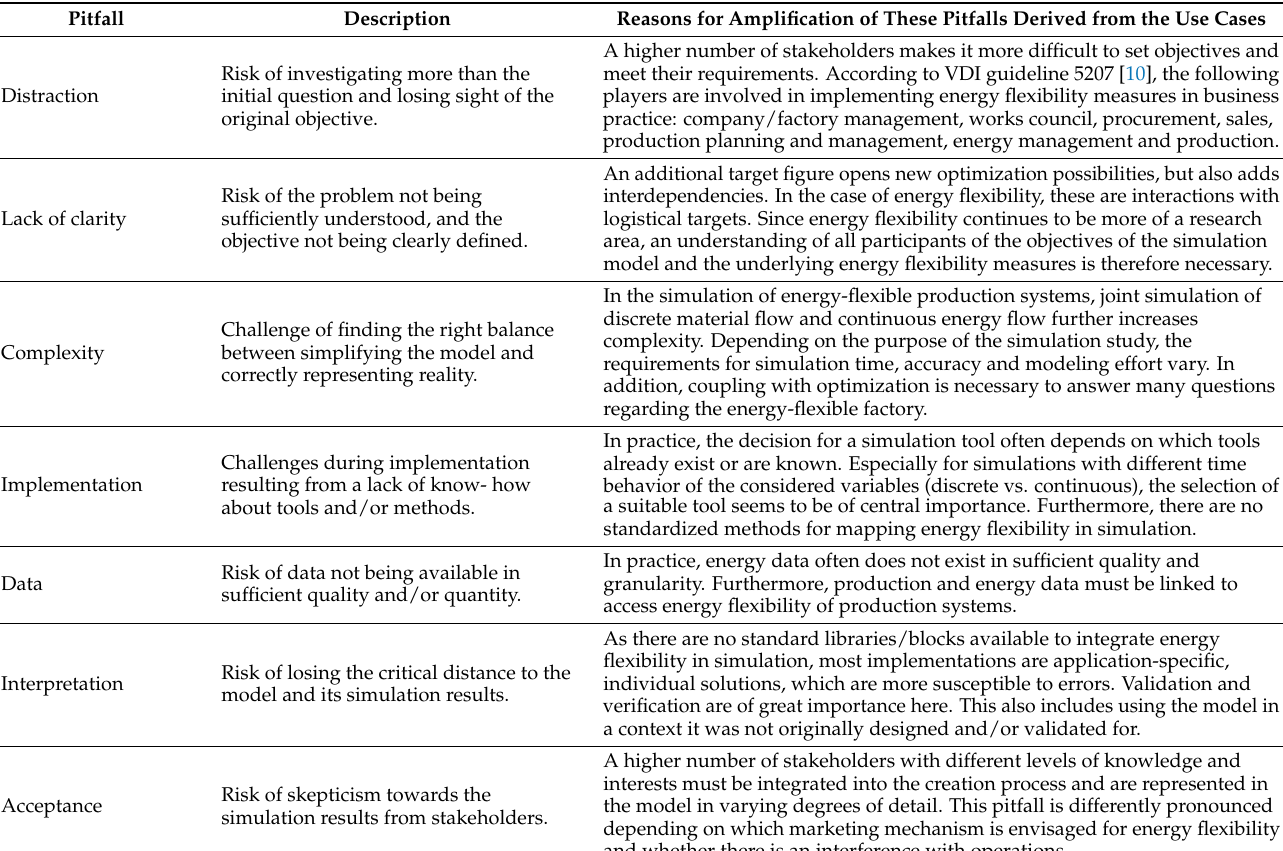
Table 1. Pitfalls of simulation modeling for energy-flexible manufacturing systems